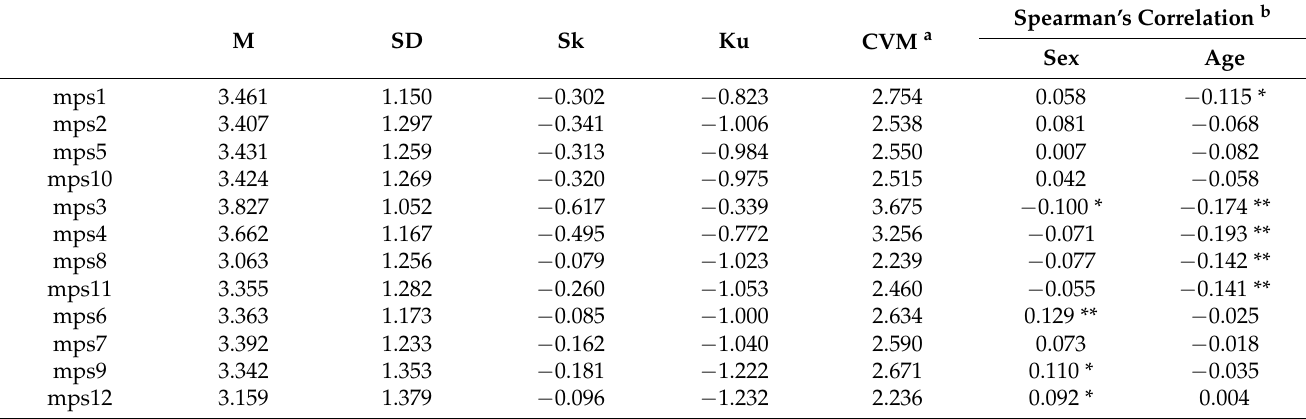
Table 2. Descriptive statistics for the MSPSS items ( n =